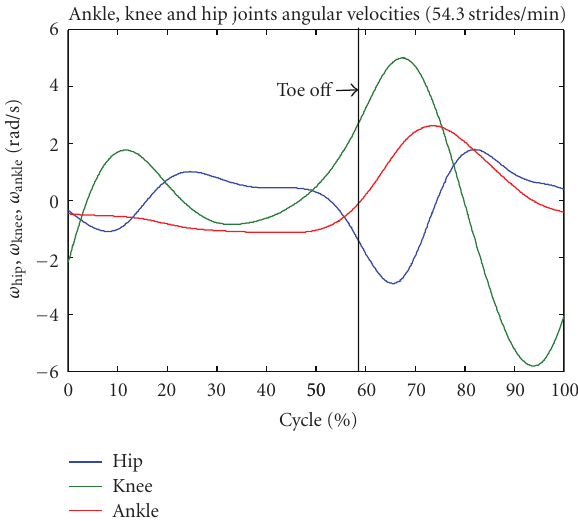
Figure 10: The hip, knee, and ankle joint angular velocities.